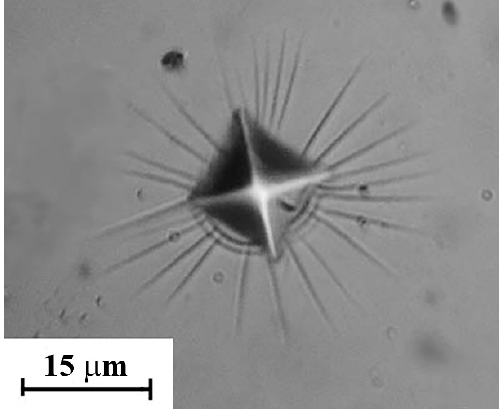
Figure 3. Typical microscopic image of the plastic deformation of AA after indentation with Vickers indenter.